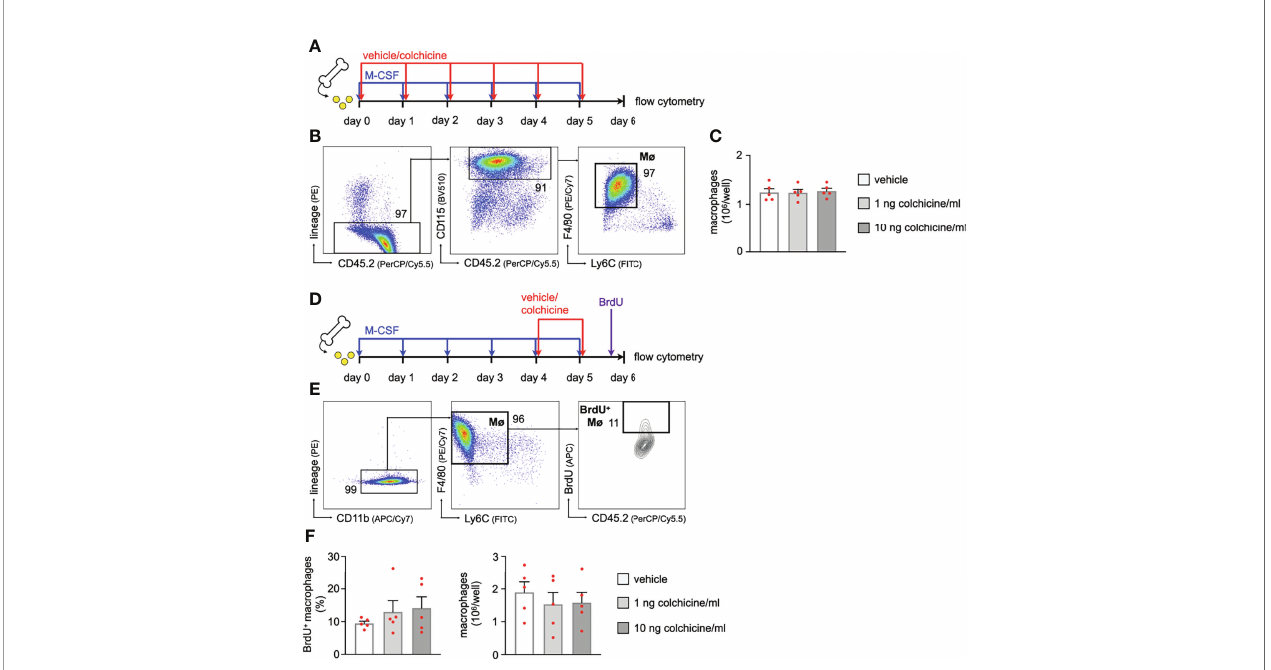
FIGURE 5 | Colchicine treatment impacts neither macrophage precursor differentiation nor macrophage proliferation. (A) Experimental scheme for precursor differentiation into macrophages (Fig. 6B+C). In brief, bone marrow cells were retrieved from one femur and cultured with M-CSF (macrophage colony-stimulating factor) for 6 days to generate bone marrow-derived macrophages (BMDM). Either vehicle or colchicine was added once every 24h starting immediately after seeding. (B) Flow cytometric gating and (C) quanti fi cation of macrophage (Mø) numbers 6 days after either vehicle or colchicine exposure ( n =5 per group, each n represents one donor animal; repeated measures one- way ANOVA with Dunnett ’ s multiple comparisons test). (D) Experimental scheme for macrophage proliferation (Fig. 6E+F). In brief, bone marrow cells were retrieved from one femur and cultured with M-CSF (macrophage colony-stimulating factor) for 6 days to generate bone marrow-derived macrophages (BMDM). Either vehicle or colchicine was added once every 24h starting 4d after seeding. BrdU (bromodeoxyuridine) was administered 2h before the harvest (day 6 after seeding). (E) Flow cytometric gating and (F) quanti fi cation of BrdU + macrophage (BrdU + Mø) frequencies (Friedman test followed by Dunn ’ s multiple comparisons test) and total macrophage numbers 48h after either vehicle or colchicine exposure (repeated measures one-way ANOVA with Dunnett ’ s multiple comparisons test). n =5 per group (each n represents one donor animal). Data are presented as mean+s.e.m. Numbers next to gates indicate population frequencies